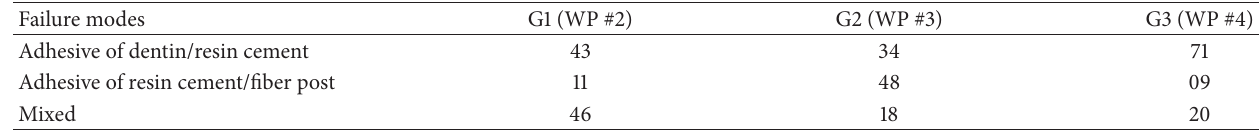
Table 3: Failure modes observed on the debonded specimens of the three experimental groups